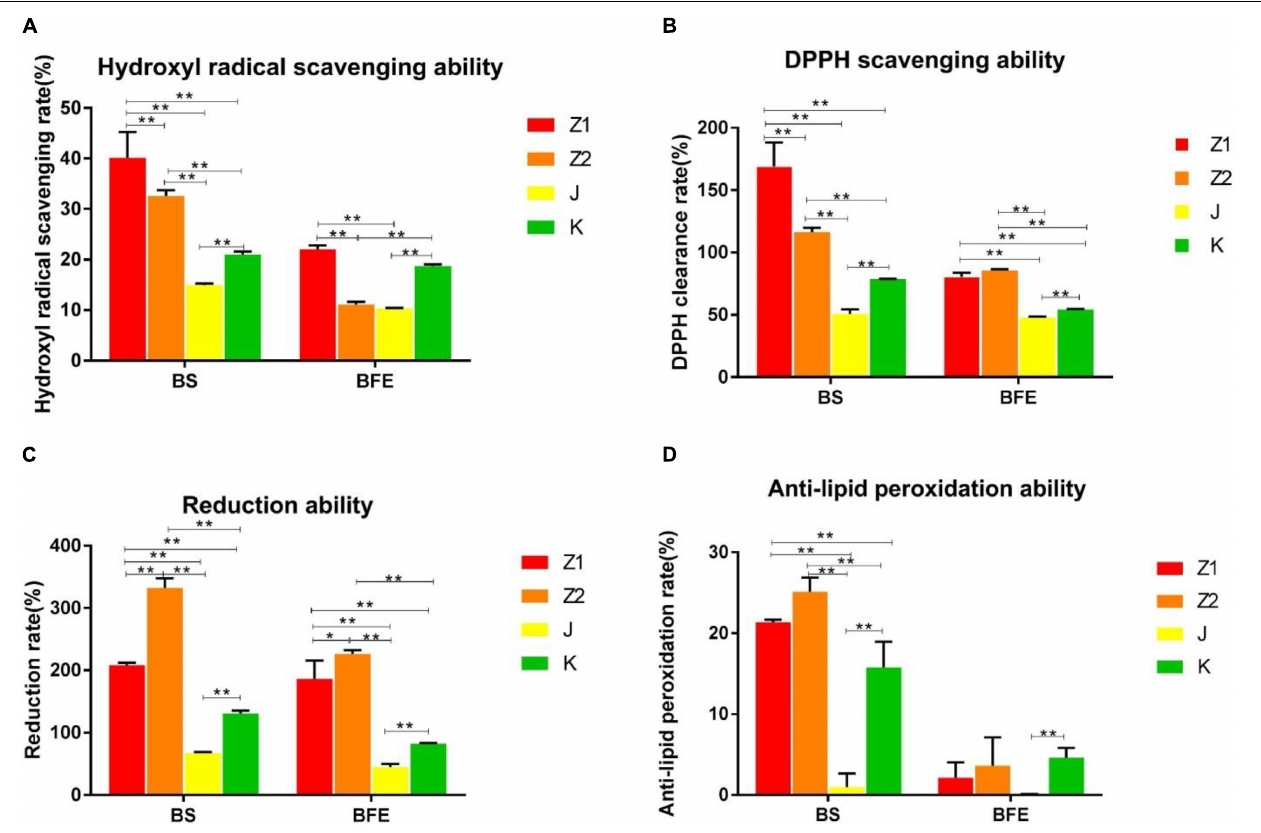
FIGURE 2 | (A,B) The scavenging ability of BS and BFE on hydroxyl radicals and DPPH. (C,D) The results of lipid peroxidation reducing ability inhibitory activity and anti-lipid peroxidation ability of BS and BFE. BS, bacterial saline suspension; BFE bacteria-free extract. The data were expressed as the mean ± SD. * P < 0.05, ** P < 0.01.